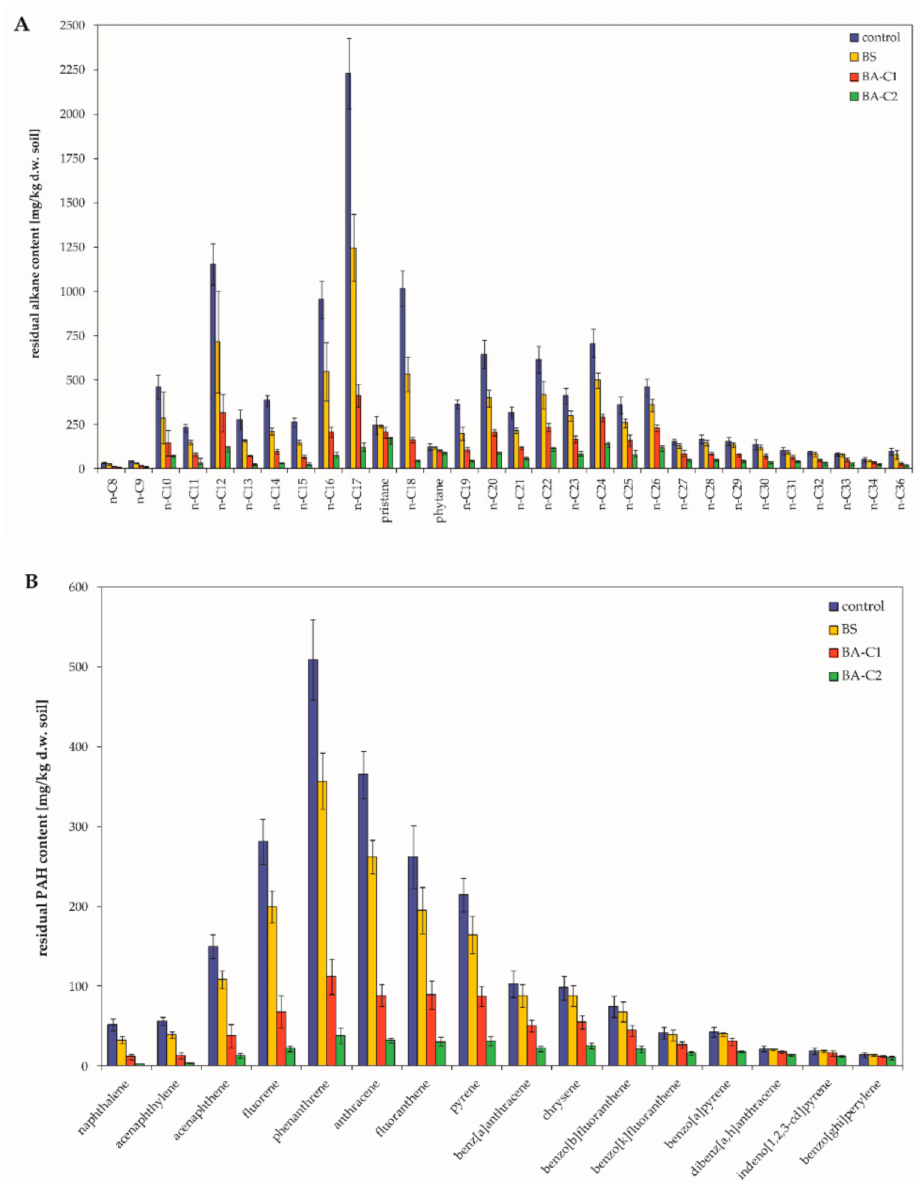
Figure 1. Residual content of ( A ) alkanes and ( B ) polycyclic aromatic hydrocarbons (PAHs) in the analyzed microcosms. Control: untreated microcosms, BS: biostimulated microcosms, BA-C1 and BA-C2: microcosms bioaugmented with the bacterial community C1 and the mixed culture C2, respectively. Data are the mean values ± SD ( n =